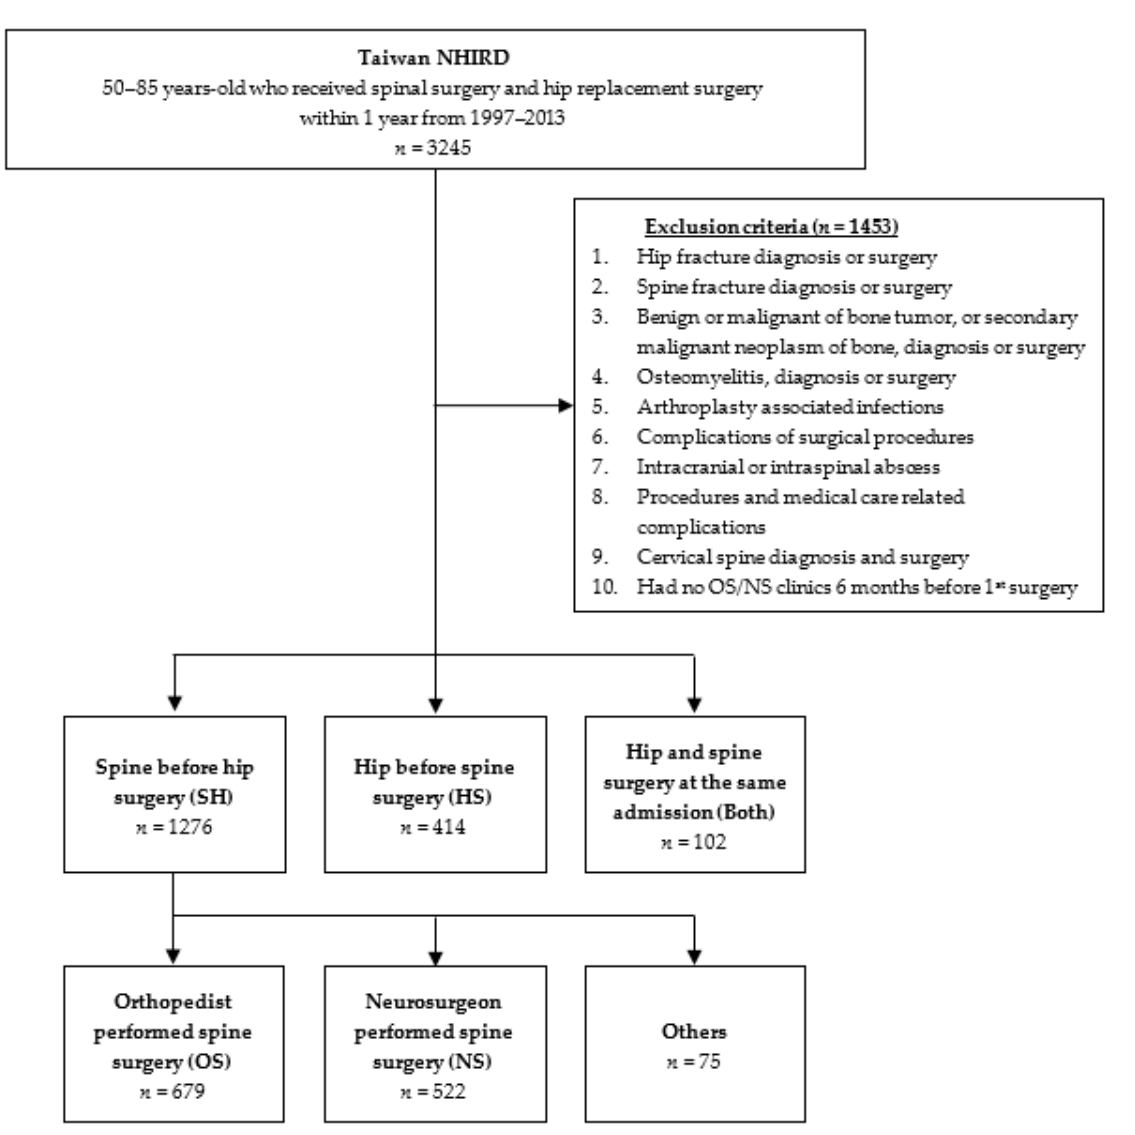
Figure 1. Flow diagram of inclusion and exclusion criteria for patient selection from the Taiwan National Health Insurance Research Database (NHIRD). Table 1. Demographics, length of stay, and Charlson Comorbidity Index (CCI) for each group.